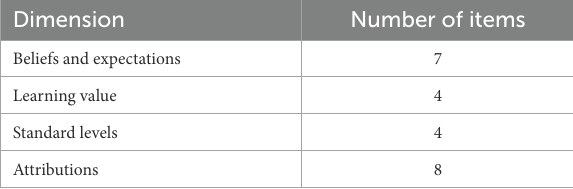
TABLE 3 Motivation dimensions in the EMAPI questionnaire.